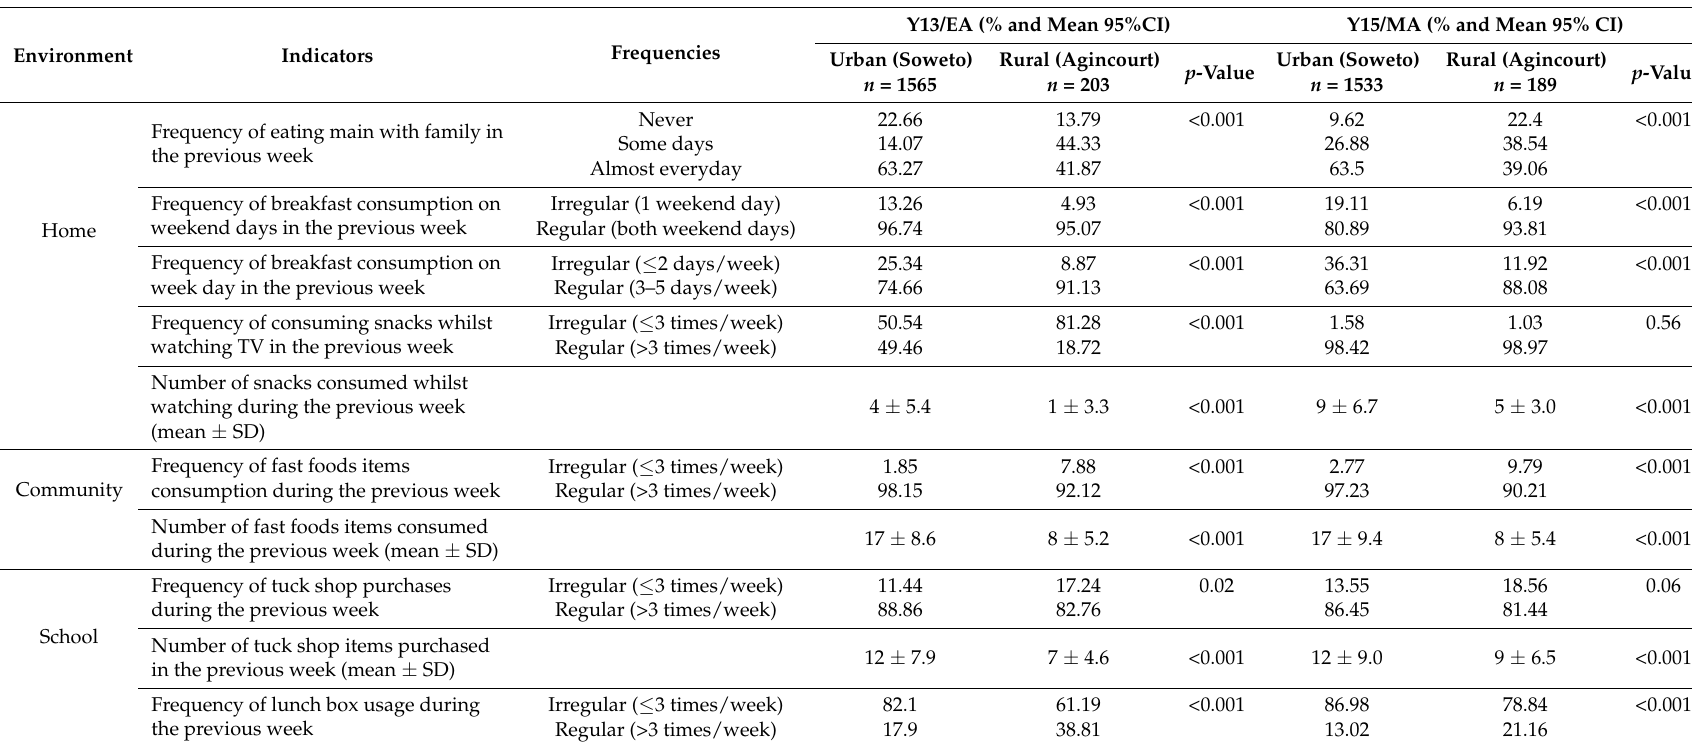
Table 4. Comparisons of dietary practices and eating habits between sites for Y13/EA and Y15/MA age